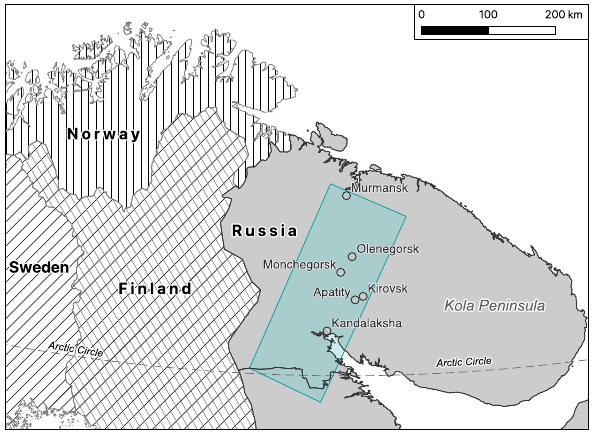
Figure 1. Location of the study area in the Kola peninsula, Russia, together with main settlements. The rectangular area of approximately 37,000 km 2 was selected for the detailed analysis as an area with high concentration of industrial activity and high quality of satellite data (low cloudiness). It lies almost completely beyond the Arctic